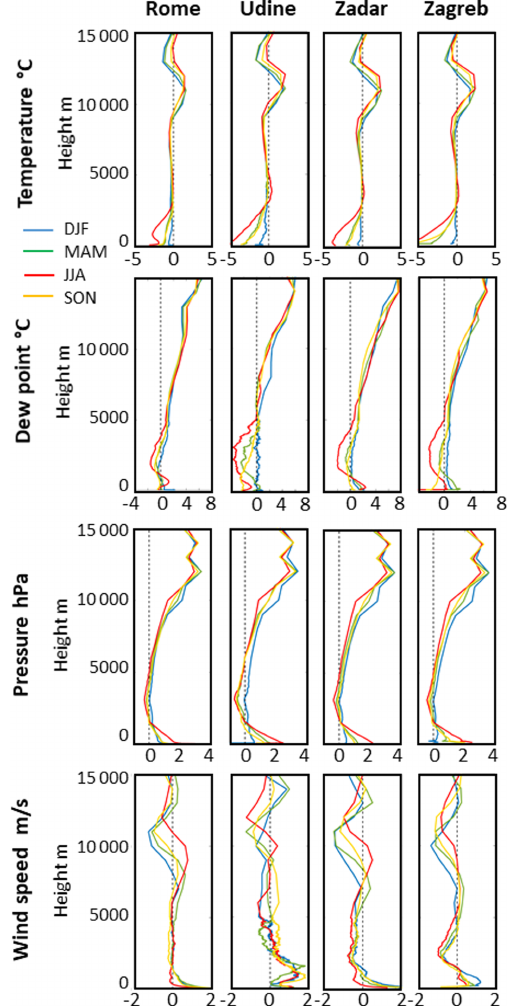
Figure 19. Seasonal variations of the median of the temperature, dew point, pressure and wind speed biases between the AdriSC WRF 3km model and the sounding measurements between the sur- face and 15km height for four different locations (Rome, Udine, Zadar and